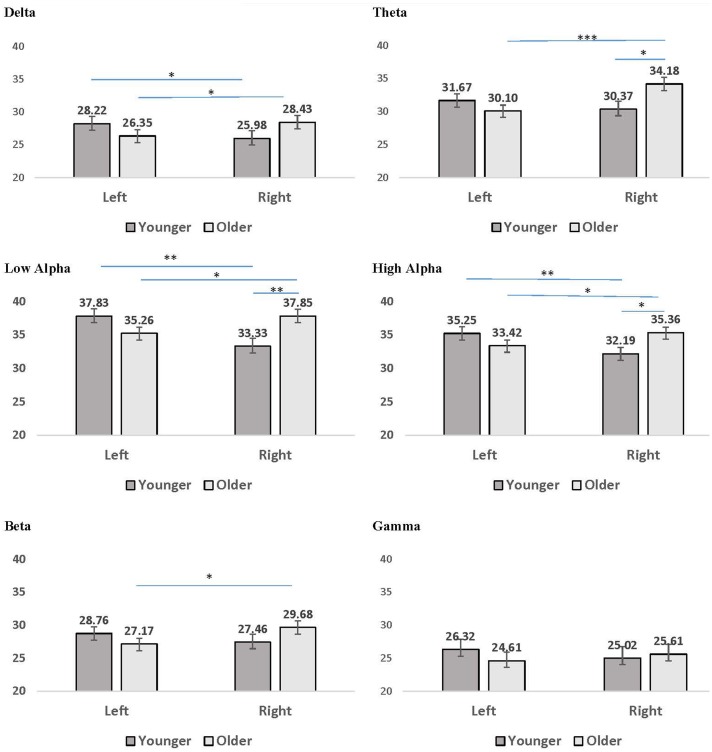
Mean coherence within the left hemisphere and right hemisphere for younger (dark gray bars) and older (light gray bars) participant groups. Error bars reflect the standard error for each condition. Lines connect conditions that differ significantly from each other, with the endpoints of each line over the middle of the bars for conditions that differ significantly from each other during pairwise comparisons. ∗p < 0.05, ∗∗p < 0.01, ∗∗∗p < 0.001.